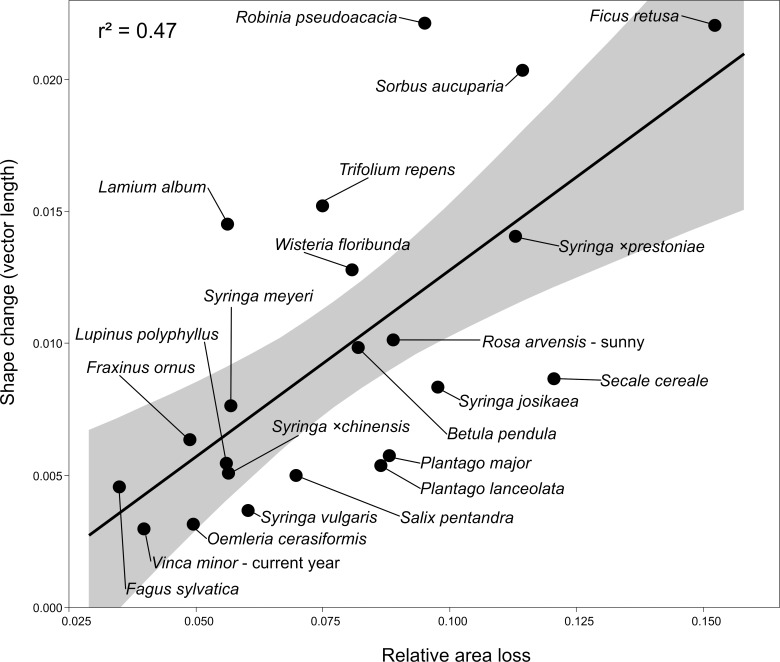
Relationship between relative area loss and shape change expressed as vector length.Mean values for species were used, with 95% confidence of fit.